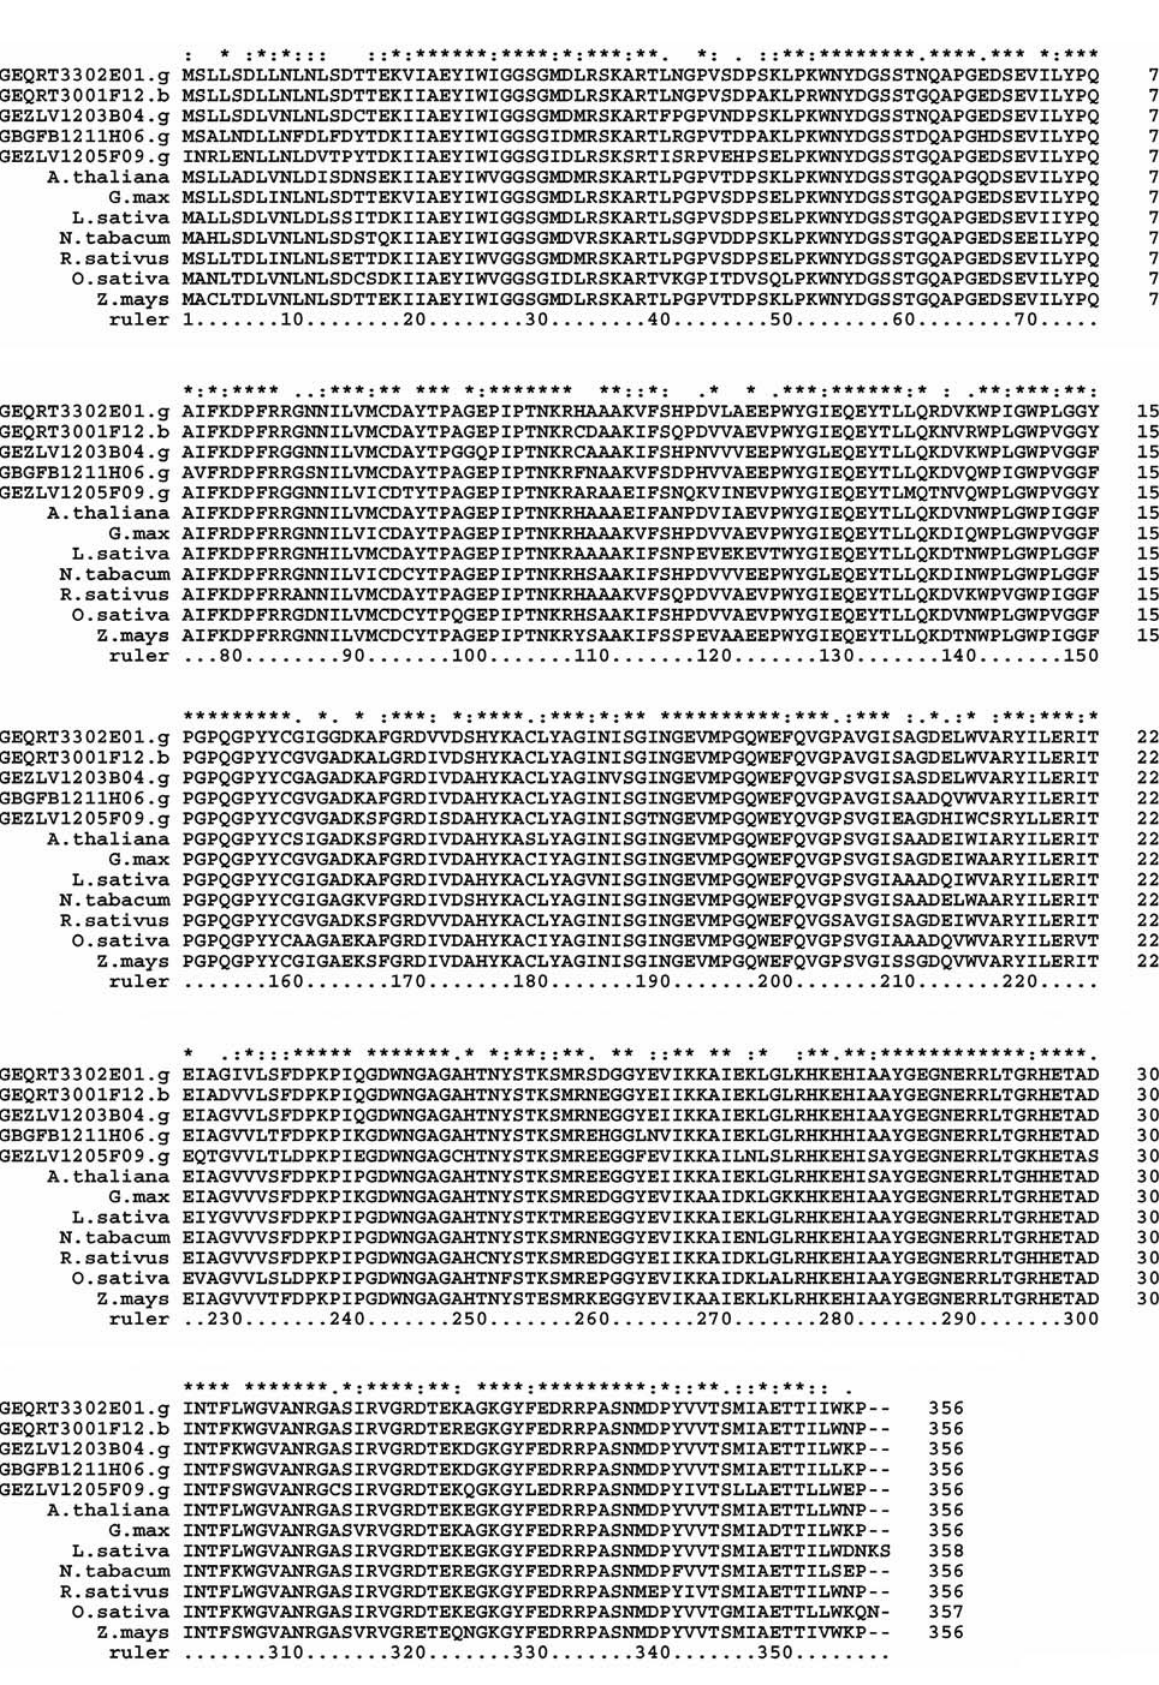
Figure 1 - Alignment of sequences corresponding to the enzyme Glutamine Synthetase from different higher plant